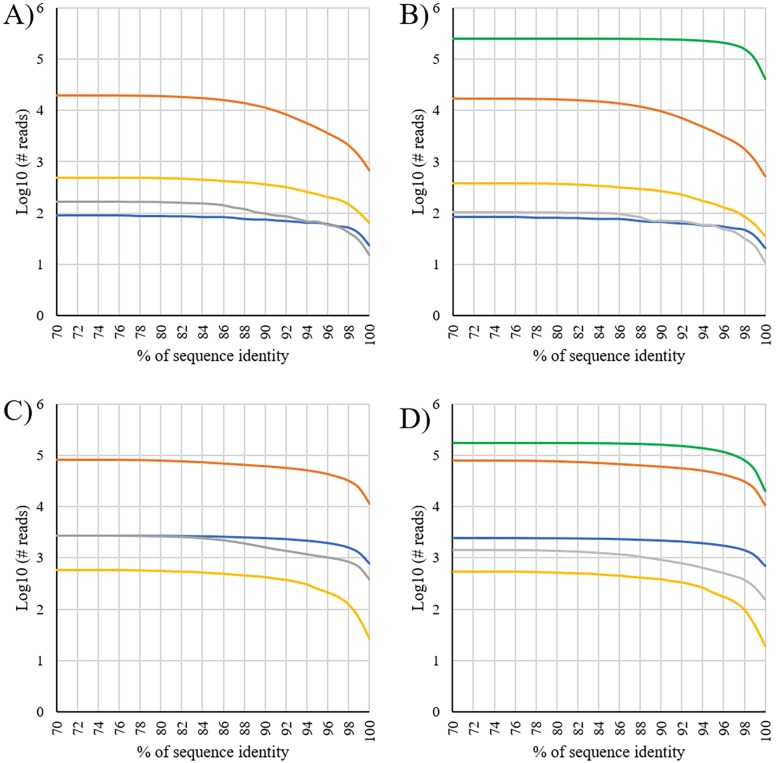
Effect of minimum sequence identity cut-off values on the number of mapped sequenced reads (considering the genus and species levels).A) Orange tree blossom honey, genus level; B) Orange tree blossom honey, species level; C) Eucalyptus tree blossom honey, genus level; D) Eucalyptus tree blossom honey, species level. Colors are as follow: blue, arthropods; yellow, plants; gray, fungi; orange, bacteria; green, viruses. Data are not reported for viruses at the genus level since this level is missing for some of them, leading to unreliable statistics. Plots are reported for a sequence identity ranging from 100 to 70% (from the left to the right) as lower values did not change the number of assigned sequences (as evidenced from the plateau reached at all levels).